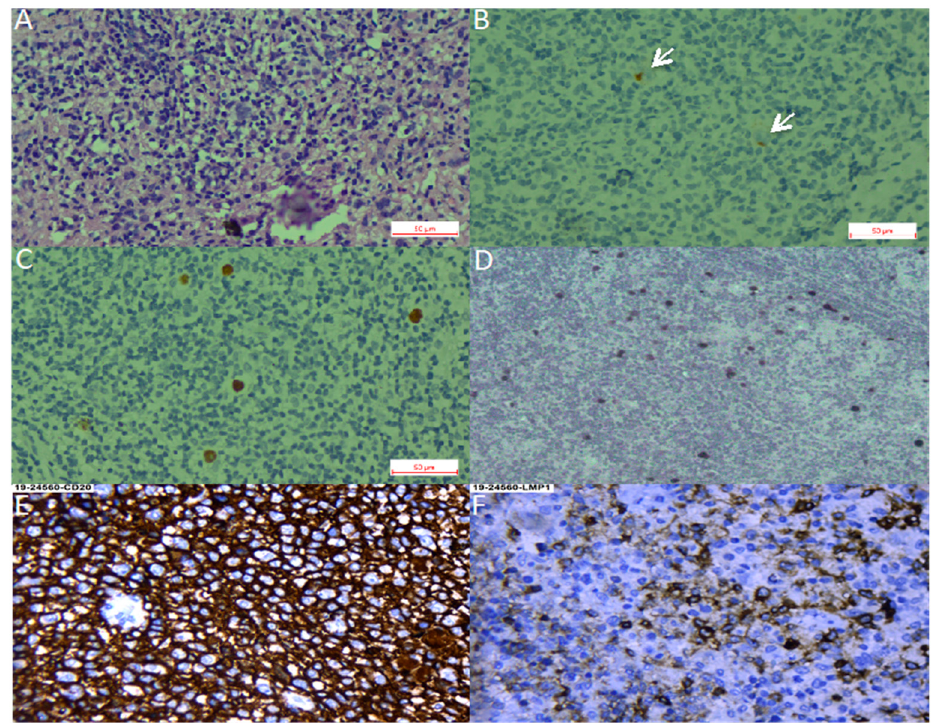
Figure 1. Hodgkin lymphoma. ( A – C ). Nodular sclerosis Hodgkin lymphoma. ( A ). Hematoxylin-Eosin staining. ( B ). CD30 staining with arrows pointing at positive Reed-Sternberg cells. ( C ). Epstein–Barr virus-encoded small RNAs (EBER) in situ hybridization. ( D ). EBER in situ hybridization of a mixed cellularity Hodgkin lymphoma, magnification 40×. ( E , F ). Diffuse large B cell lymphoma, magnification 40×. ( E ). CD30 staining. ( F ). LMP1 (latent membrane protein 1) staining.